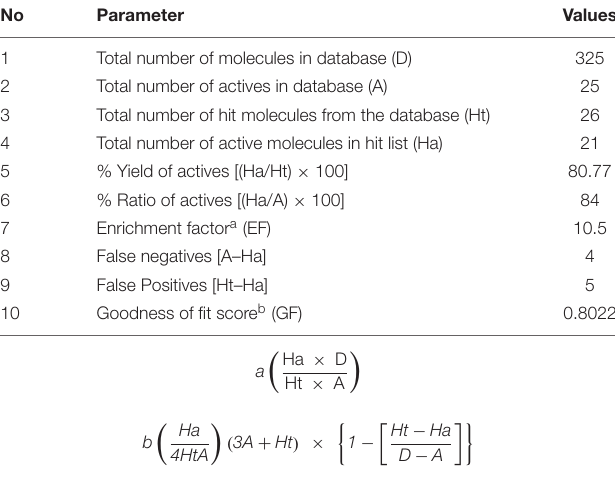
TABLE 3 | Statistical parameters of the decoy set for Hypogen1.